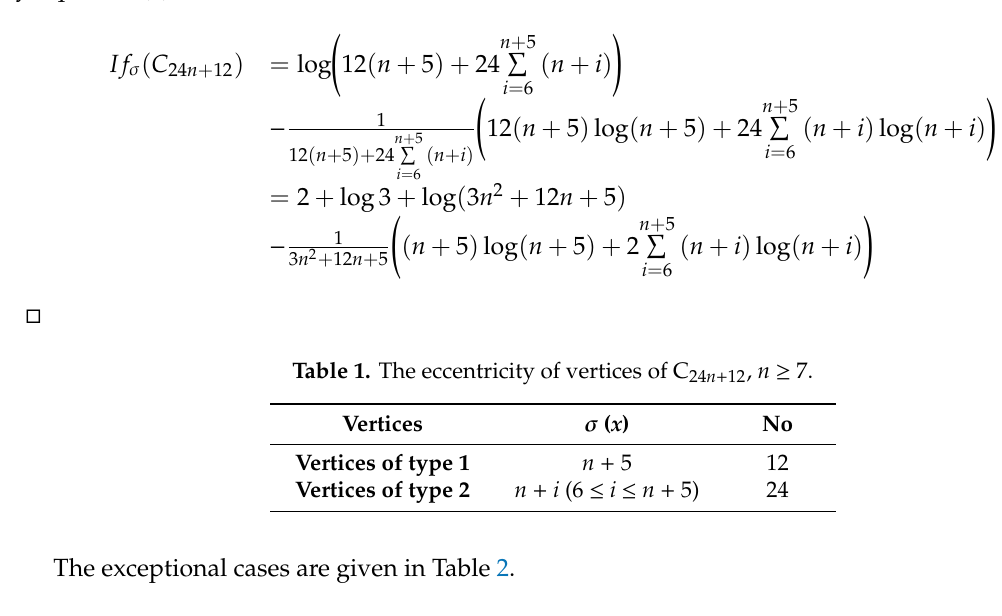
Table 2. Some exceptional cases of C 24 n + 12